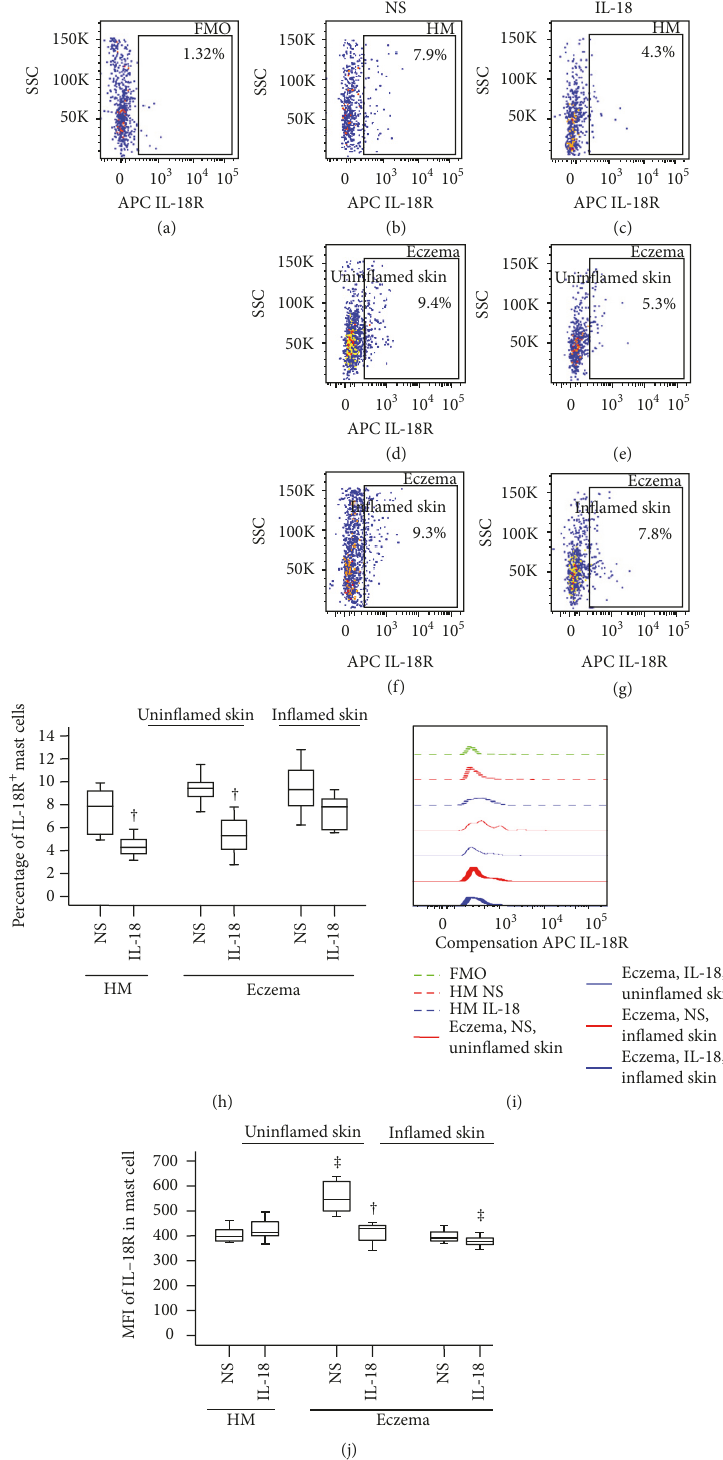
Figure 5: Flow cytometry analysis of expression of IL-18 receptor (IL-18R) in dispersed skin mast cells of mice. (a) FMO for IL-18R; (b), (d), and (f) show percentage of IL-18R+ mast cells in skin of healthy mice (HM) and in normal or in fl ammatory skin of eczema mice treated with normal saline (NS), respectively. (c), (e), and (g) show percentage of IL-18R+ mast cells in skin of healthy mice (HM) and in normal or in fl ammatory skin of eczema mice treated with IL-18, respectively. (h) represents median percentage values of mast cells in mouse skin. (i) shows representative fl ow cytometric fi gures of mean fl uorescence intensity (MFI) of IL-18BP+ mast cell. (j) demonstrates changes in MFI of IL-18BP+ mast cell. Data shown are the median (range) value from 6 di ff erent mice. ∗ P < 0 05 in comparison with NS group (paired Mann – Whitney U test) ‡ P < 0 05 compared with HM NS group. † P < 0 05 compared with corresponding NS